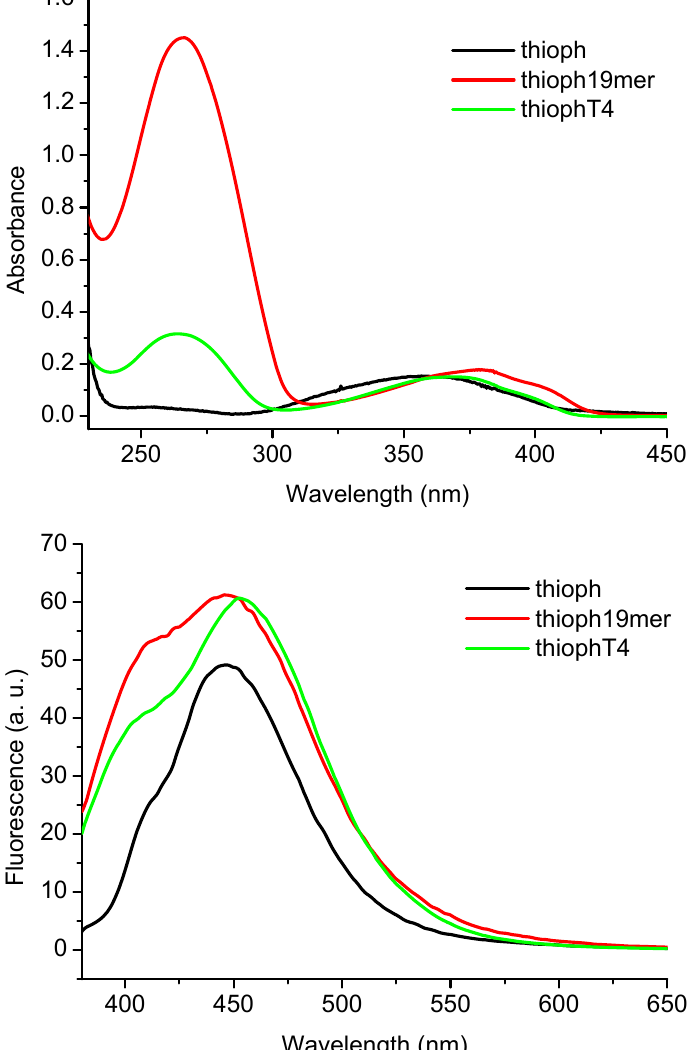
Figure 1. Absorbance (top panel) and fluorescence emission (bottom panel) of: oligothiopene 1 (black line), conjugates 19-mer-oligothiophene (red line) and tetrathymidine T -oligothiophene conjugate (green 4